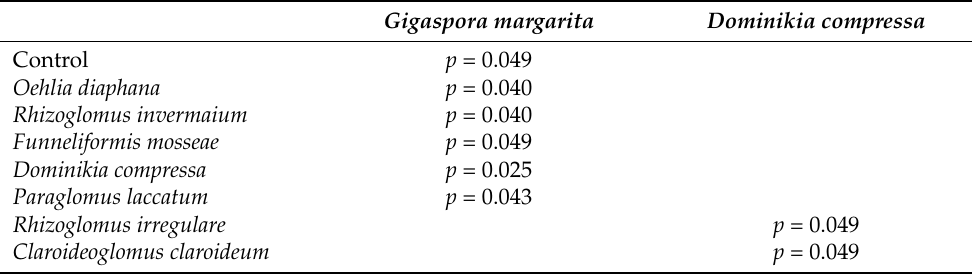
Table 1. Significant differences between different AMF species in plant biomass development of E. crus-galli obtained via all-pairs comparisons after Kruskal–Wallis rank sum test (non significant differences between AMF species are not shown).